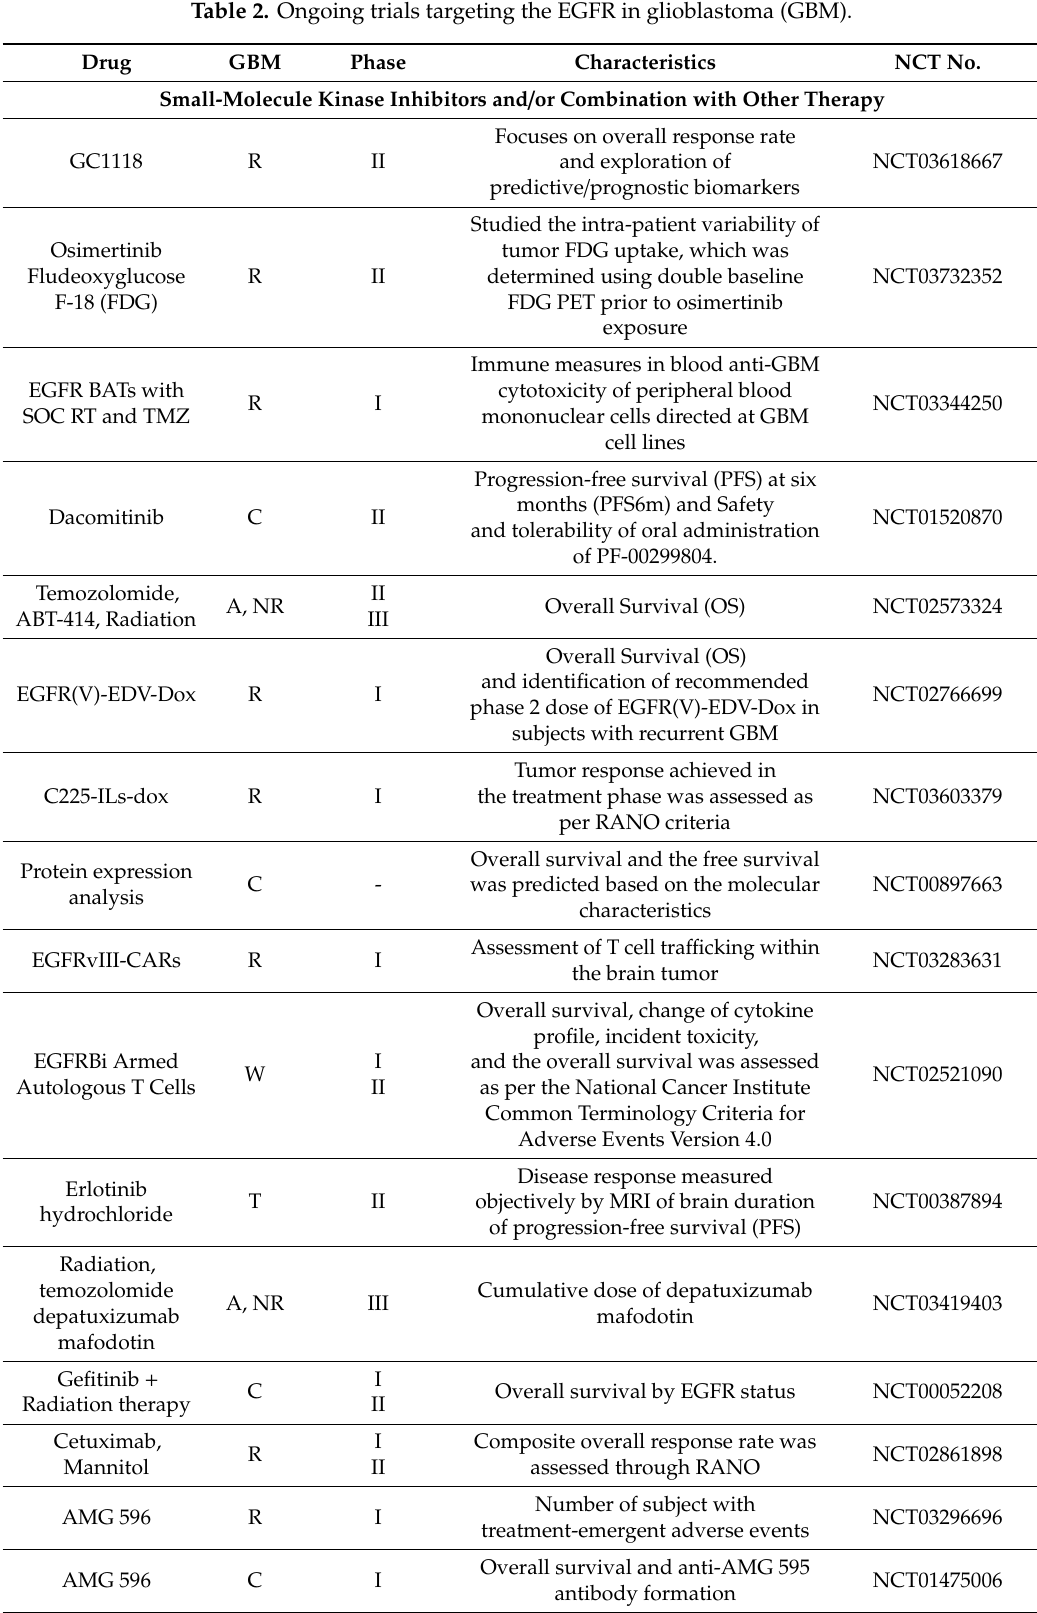
Table 2. Ongoing trials targeting the EGFR in glioblastoma